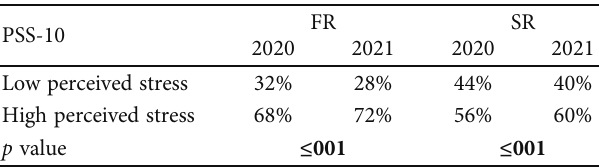
Table 4: PSS-10 results ( N = 300